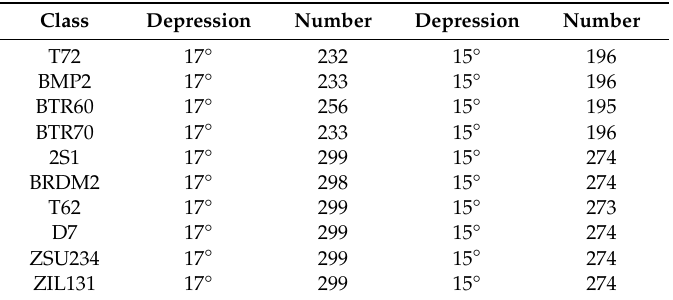
Table 1. Description of the real SAR dataset.